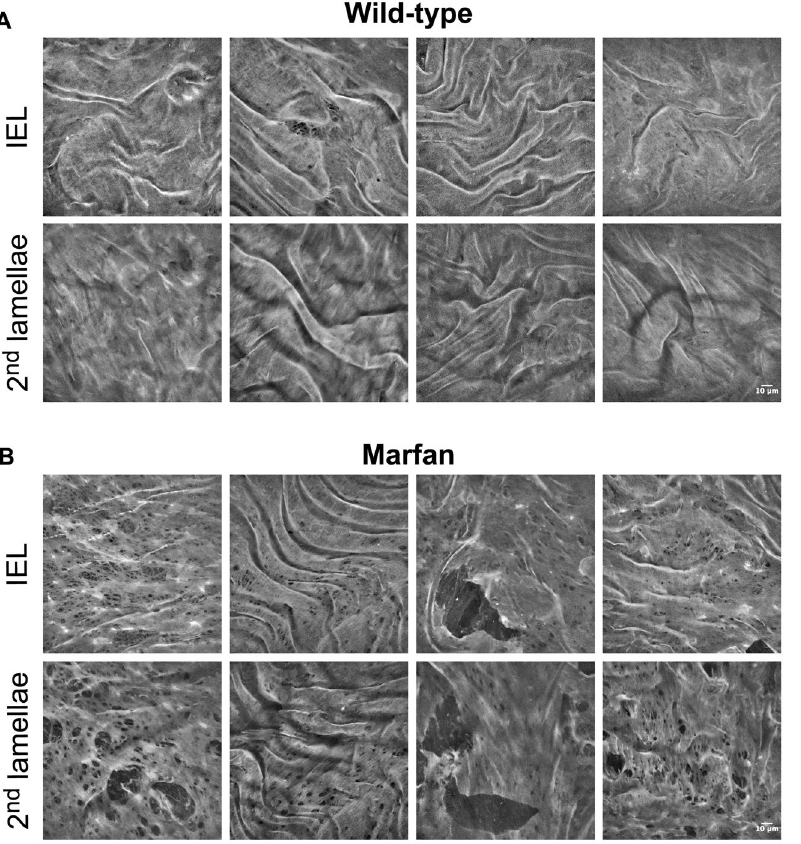
Figure 3. Representative en-face images of wild-type and Marfan elastic laminae. Maximal projections of segmented IEL and 2 nd lamina of WT ( A ) and Marfan ( B ) aortae. IEL and 2 nd laminae images of each column belong to the same image stack acquisition. In addition, each column corresponds to a different animal. Fenestrae are seen as black holes of variable size. Big polygonal black holes are considered ruptures, and are excluded from fenestrae quantification. Scale bar, 10 μ